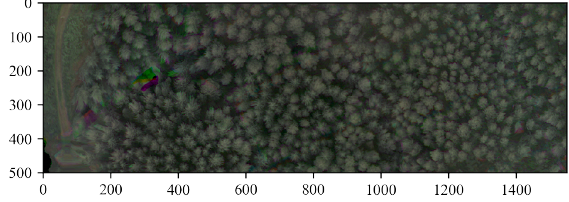
Figure 4. Training data for the anomaly detection from the forest. Data has been captured from the UAV with 9 cm GSD.